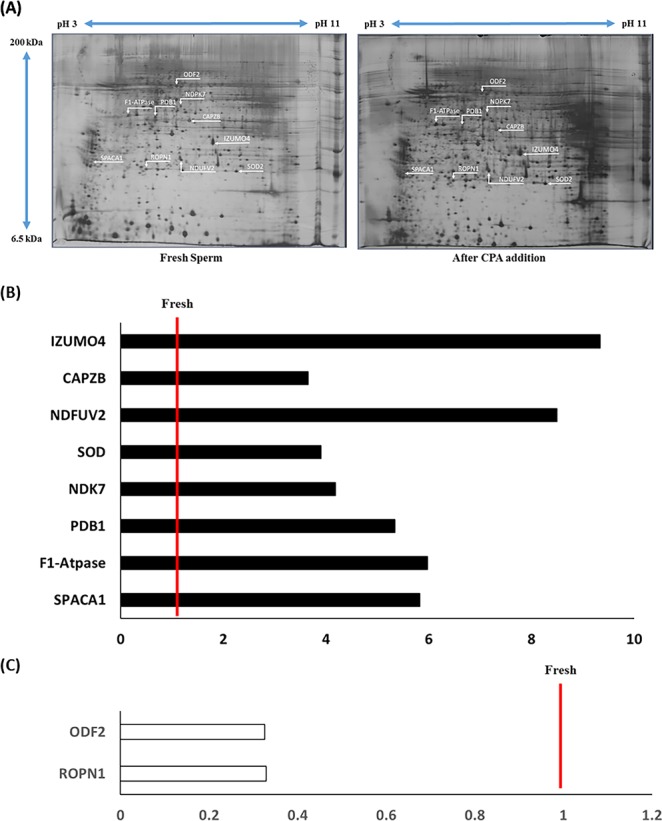
Representative 2-DE gel image of protein separation.Protein spots from (A) fresh spermatozoa and after CPA addition. (B) The expression of eight proteins increased significantly after CPA addition. (C) The expression of two proteins decreased significantly after CPA addition. Differentially expressed (>3-fold) proteins were determined by comparing the normalized spot value of particular protein between the fresh and samples after CPA addition (*P < 0.05, n = 9). The red line indicates the landmark of equal levels for fresh spermatozoa. Each experiment was conducted three times.